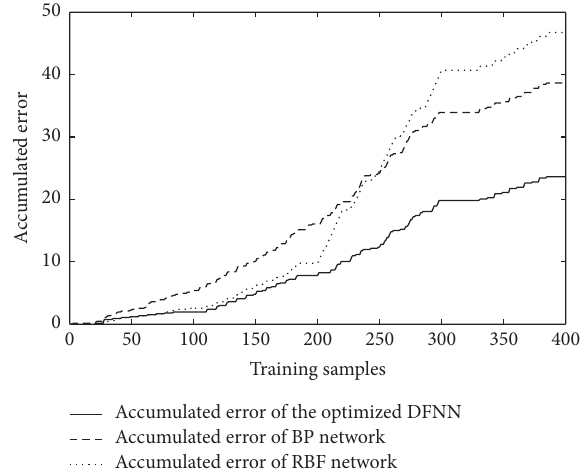
Figure 17: Training accumulated errors of three networks.